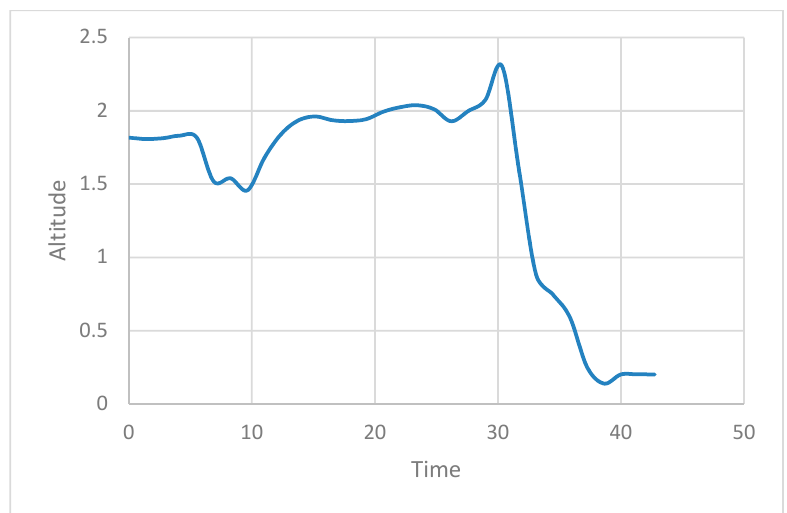
Figure 13. UAV flight altitude without security framework in native ROS.